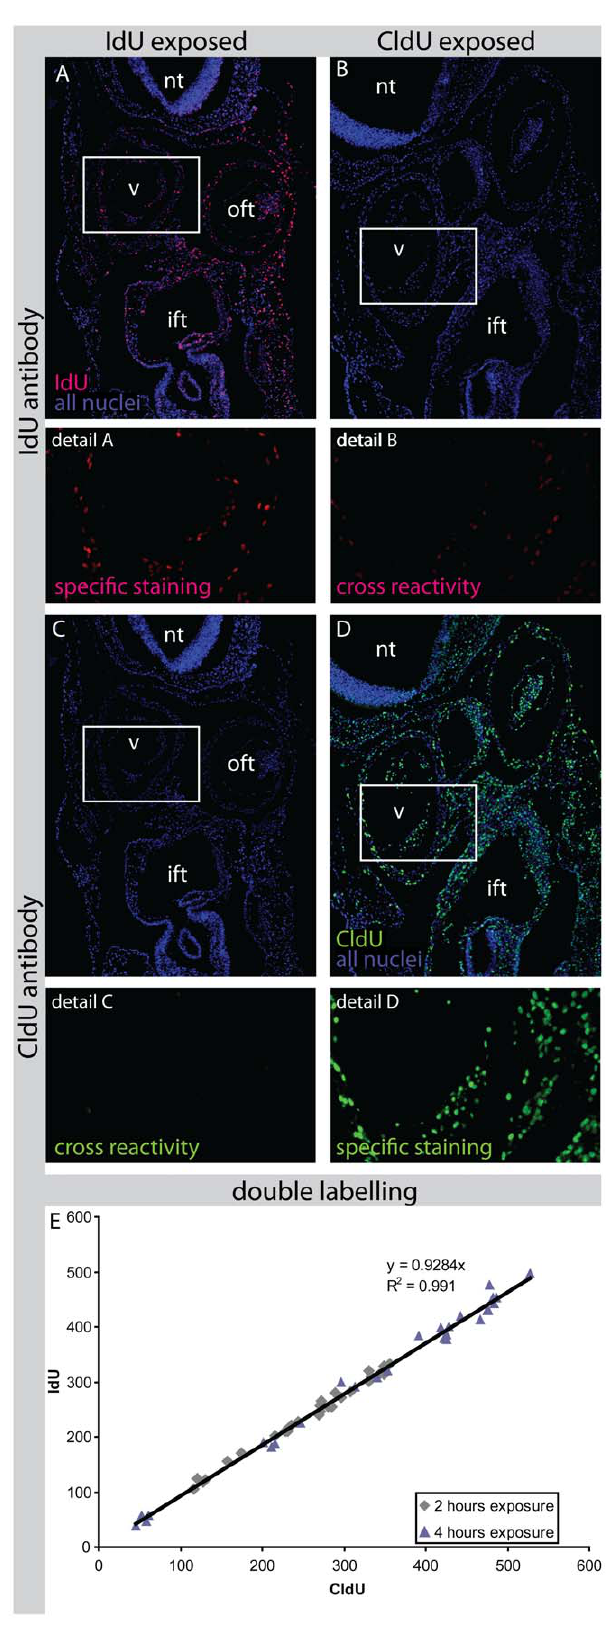
Figure 2. Cross-reactivity and validation of antibody staining. Section of an embryo exposed to IdU shows specific staining using an